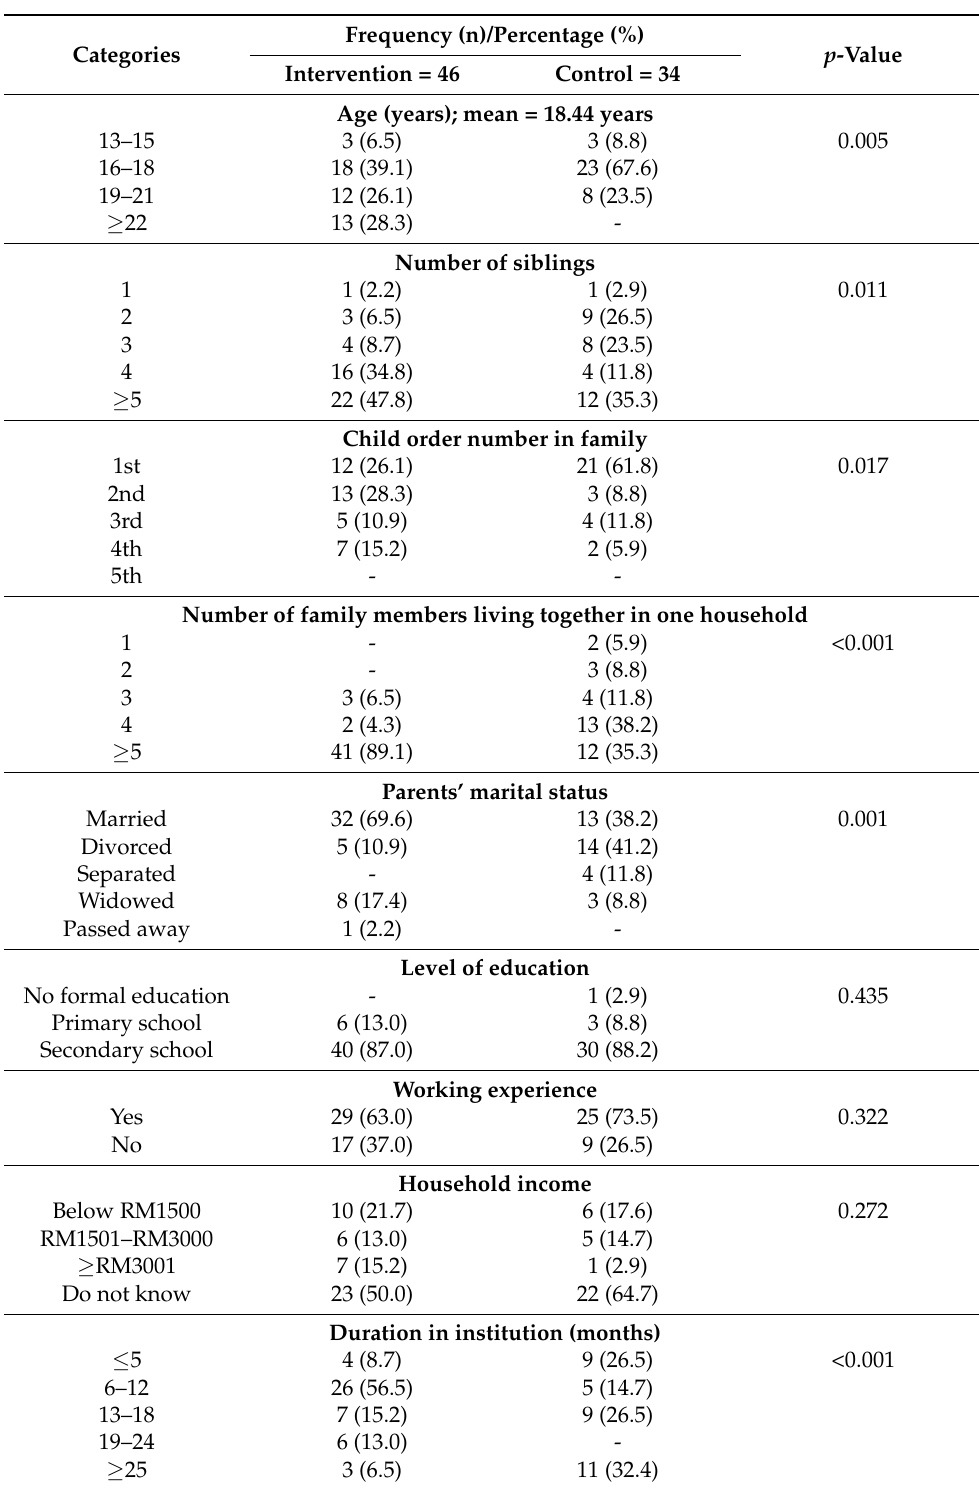
Table 2. Socio-demographic characteristics of